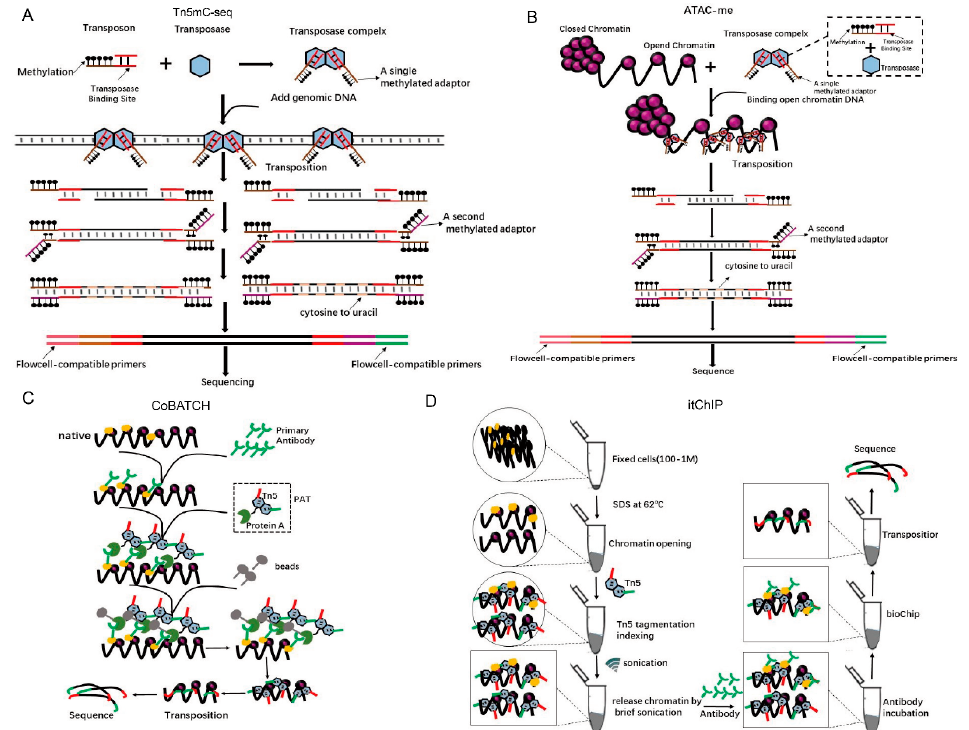
Figure 6. Using Tn5 in epigenetics. ( A ). Principle and s cheme for Tn5mC. Tn5 transposases loaded with a methylated adaptor (brown) attack genomic DNA. Oligonucleotide replacement methods anneal the second methylated adaptor (purple) and perform gap repair. Bisulfite treatment converts unmethylated cytosine to uracil (gray) and PCR is performed to add primers (pink, green) that are compatible with the external flow cell. Methylation is represented as a black lollipop. ( B ).